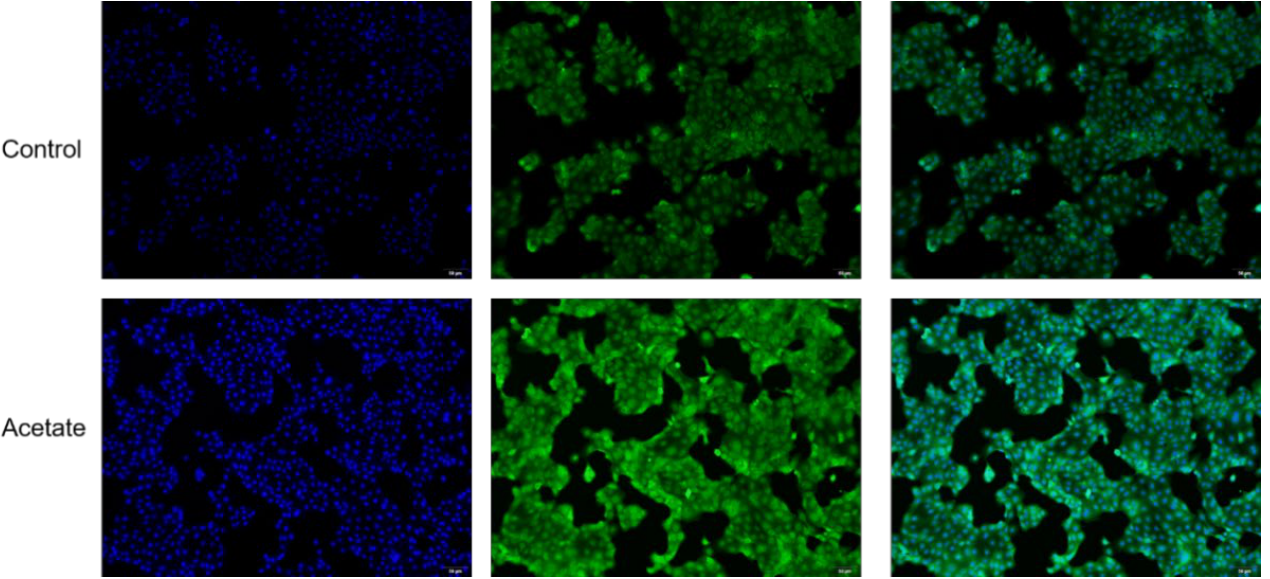
Figure 2. Bodipy staining showing lipid droplets in cultured BMECs induced with acetate. Lipid droplets were stained with Bodipy 493/503 (green), and nuclei were stained with DAPI (blue). Bar = 50 μm.